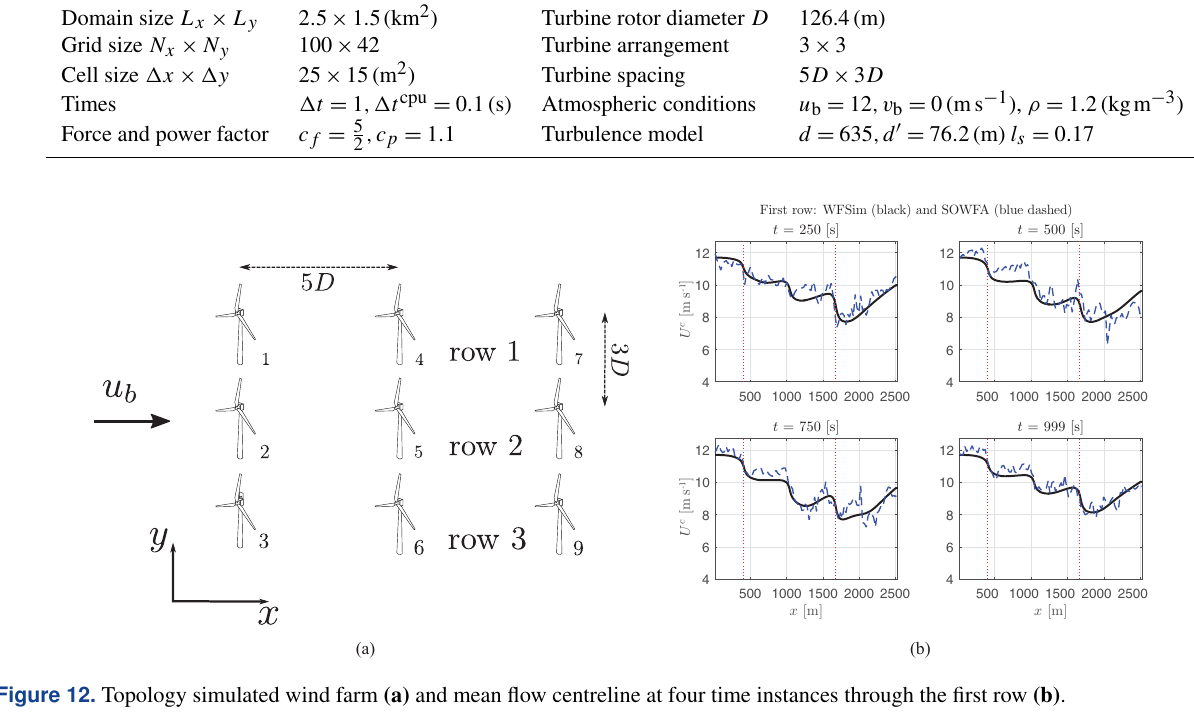
Figure 12. Topology simulated wind farm (a) and mean flow centreline at four time instances through the first row (b) .